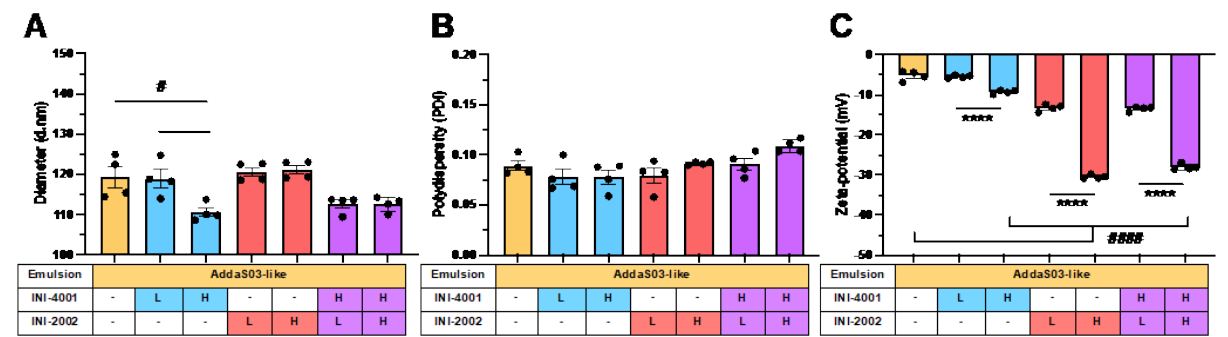
Figure 3. Effect of incorporation of INI-4001 and INI-2002 on hydrodynamic diameter, polydispersity (PDI), and zeta potential in AddaS03-like emulsions. INI-4001 or/and INI-2002 were incorporated alone or in combination into AddaS03-like emulsions at “low” (L) 0.175 mM or “high” (H) 1.75 mM target concentrations. Dynamic light scattering was used to measure ( A ) hydrodynamic diameter (Z.Avg, nm), ( B ) PDI, and ( C ) zeta potential (mV) at a pH of 6.7–6.8. Physical properties are given as mean ± SEM with black dots representing each replicate emulsion ( n = 4). A one-way ANOVA with a post hoc Tukey’s test for multiple comparisons demonstrated significant differences between group means within compound concentrations (**** p < 0.0001) or when compared or to the AddaS03-like vehicle (# p < 0.05, #### p < 0.0001).